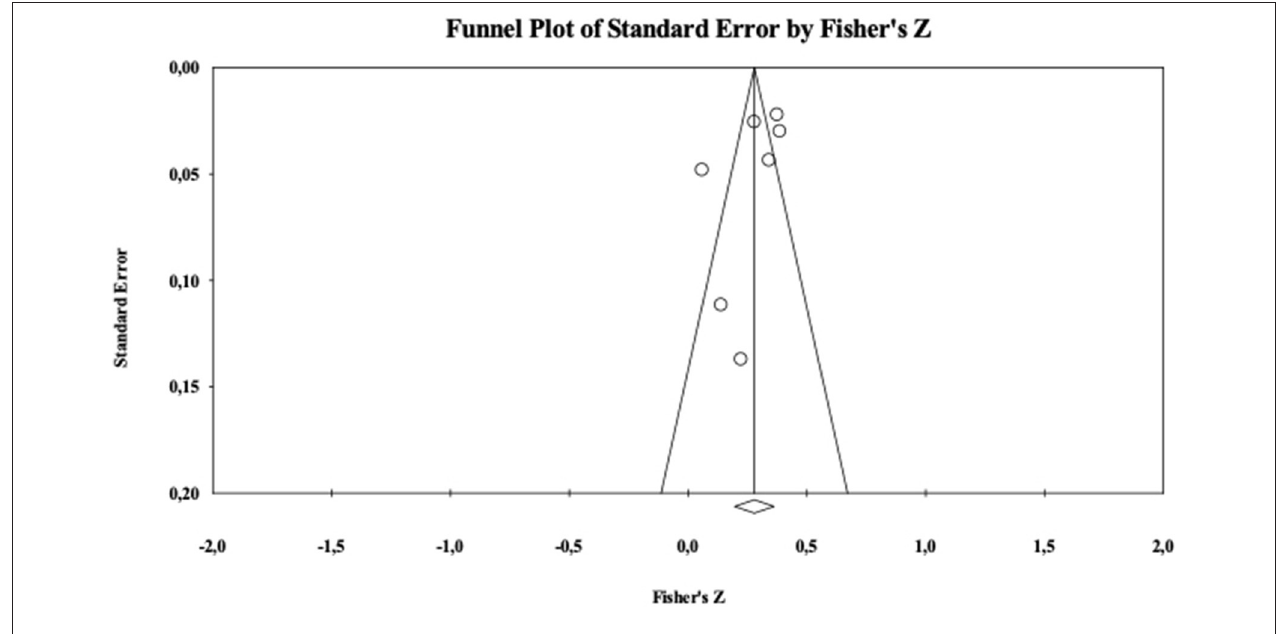
FIGURE 4 | Funnel plot for values.